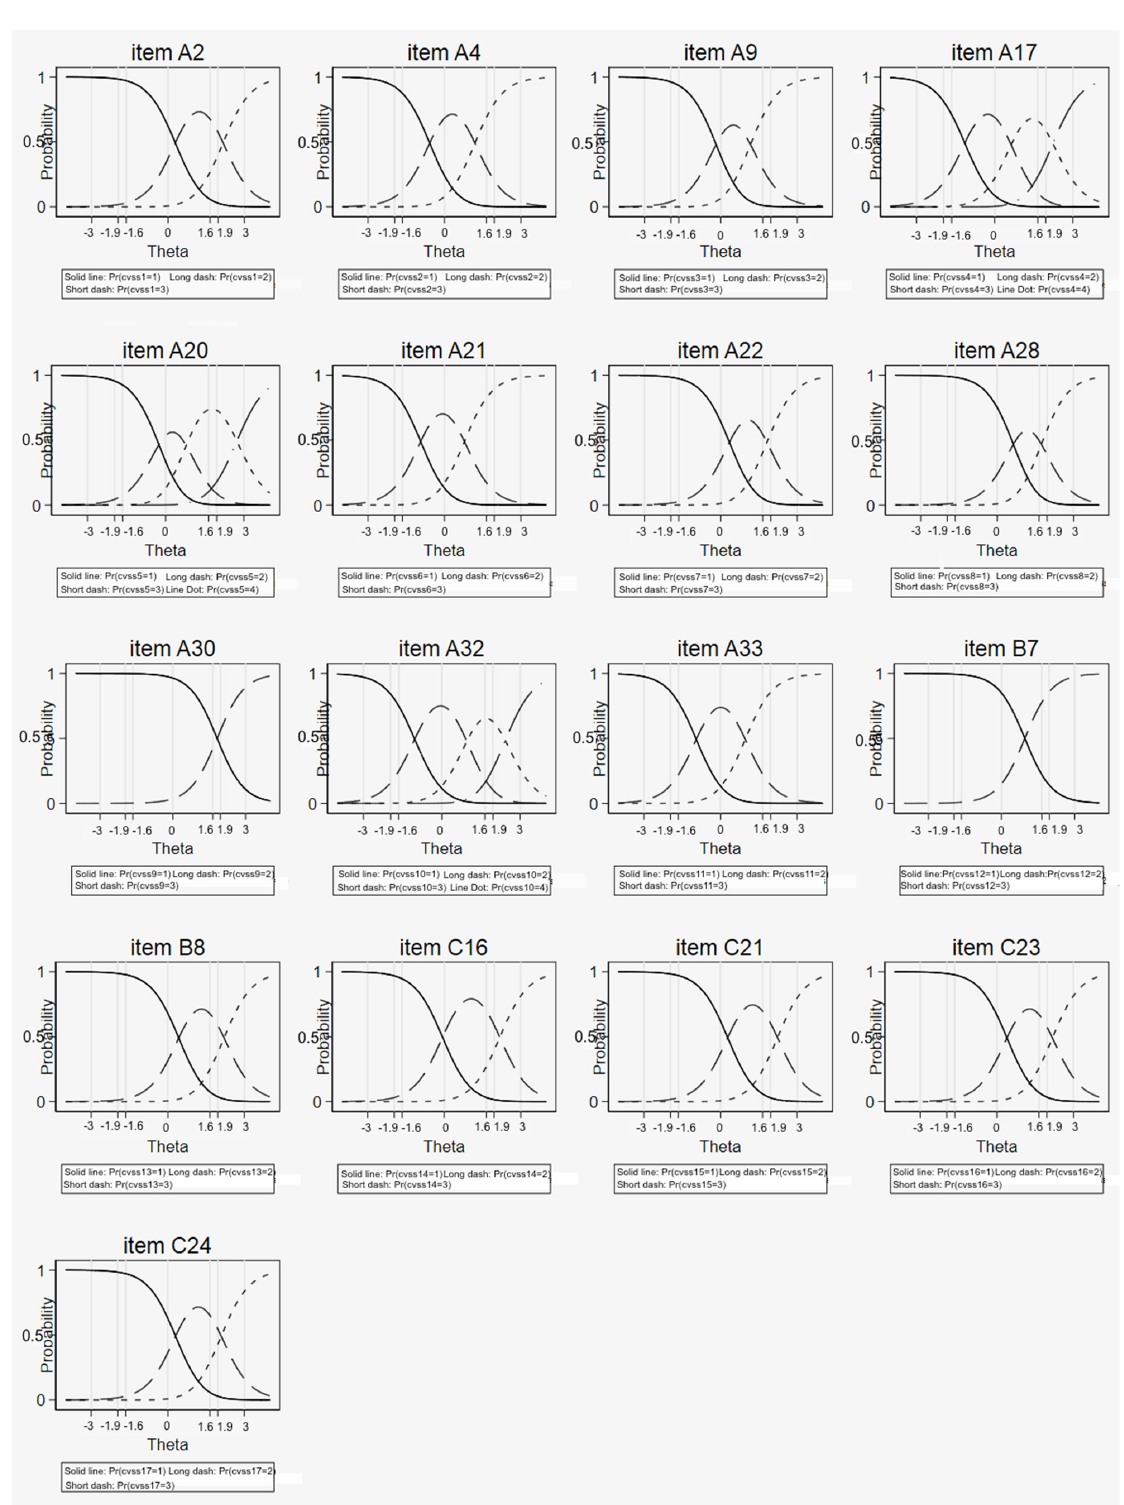
Figure 4. Category characteristic curves (CCC) and empirical proportions for each of the 17 CVSS items from the graded response model (IRT analysis) of the Italian version of the CVSS17.